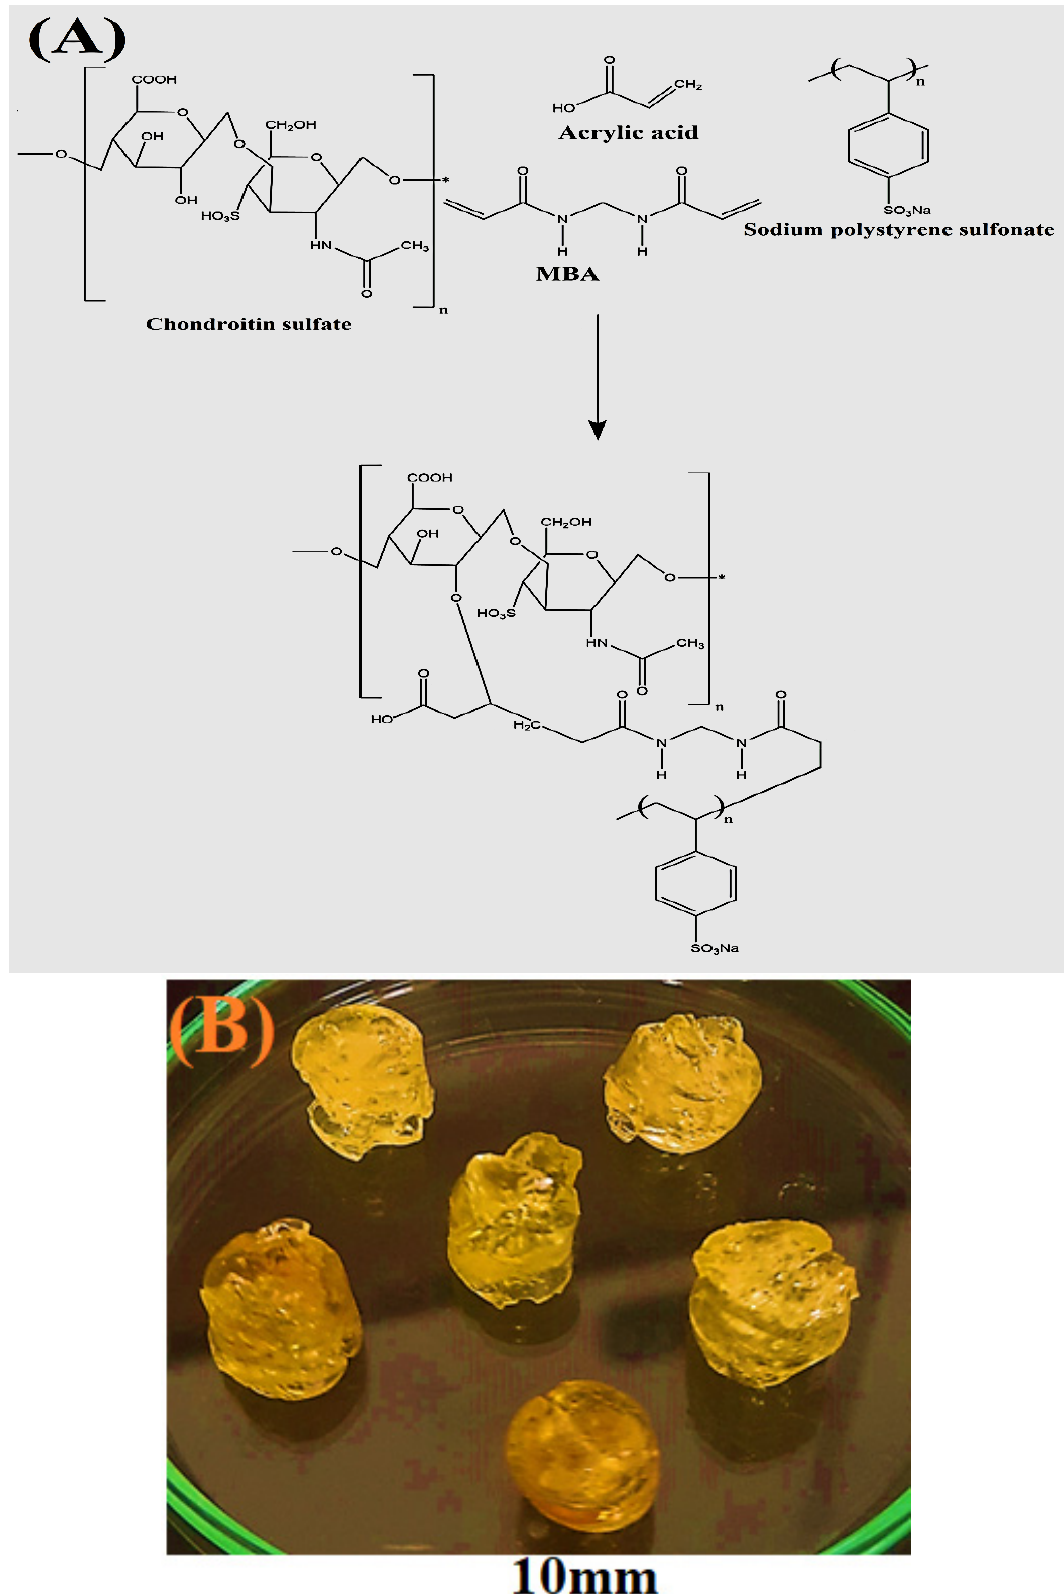
Figure 1. ( A ) Proposed chemical structure and ( B ) physical appearance of Cs/SpsCpAca hydrogels.